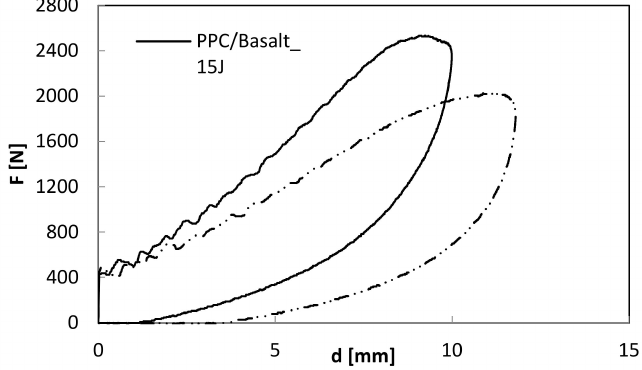
Figure 9. Load–displacement curves at indentation: comparison between BS_PP and BS_PPC; U = 15 J.